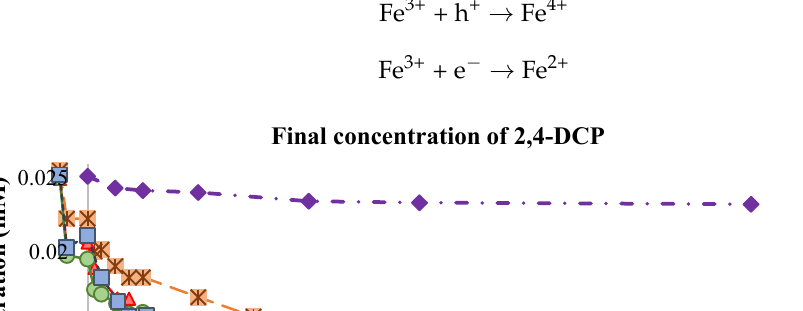
Figure 11. Schematic display of the electronic band structure of Fe/TiO 2 –7. Figure 12 presents the photoreaction kinetics, assuming a Langmuir–Hinshelwood (LH)) model as described by Equation (22) [67]: 𝑟 (cid:3404) (cid:3398) 𝑑𝐶 𝑑𝑇 (cid:3404) 𝑘 𝐿𝐻 × 𝐾 × 𝐶 𝑡 1 (cid:3397) 𝐾 × 𝐶 𝑡